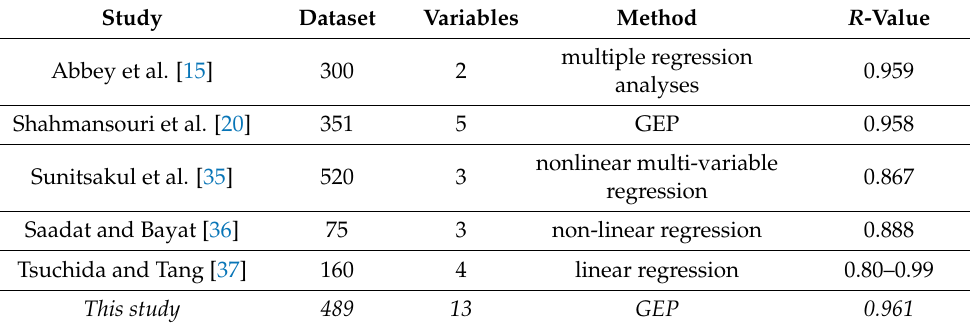
Table 6. Performance comparison of prediction